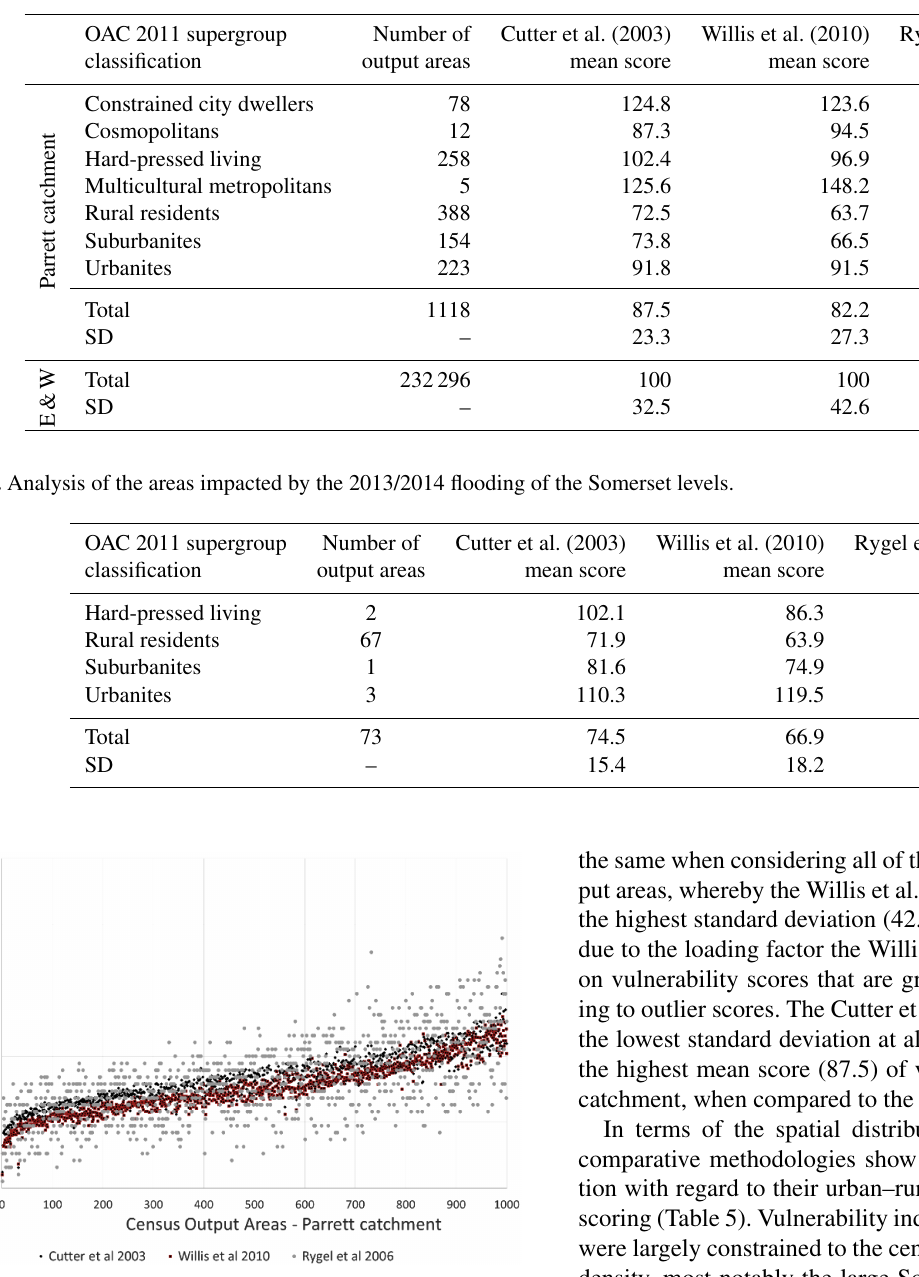
Figure 5. Output area comparison of social vulnerability index scores for the Parrett